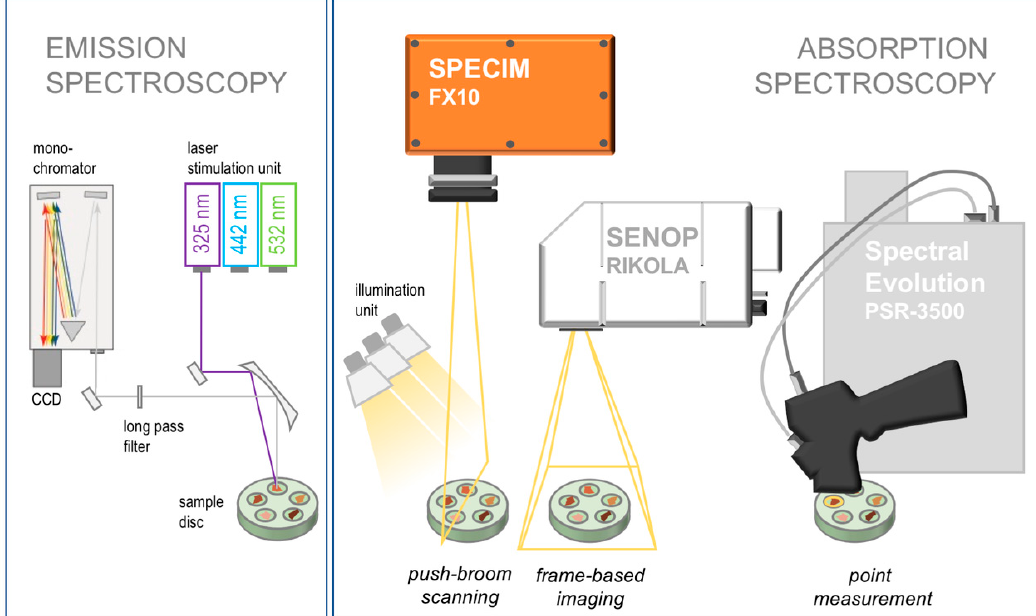
Figure 1. Schematic illustration of the technical setup (not to scale).